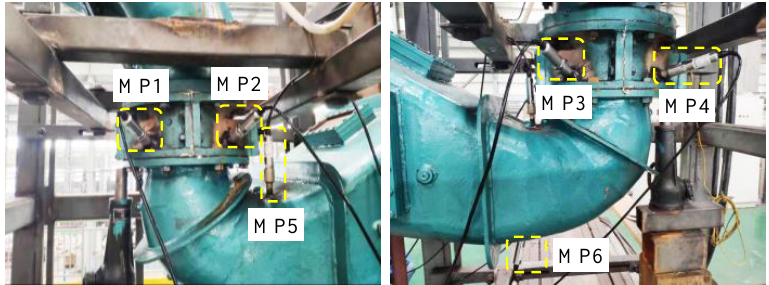
Figure 2. Monitoring points of pressure pulsation.